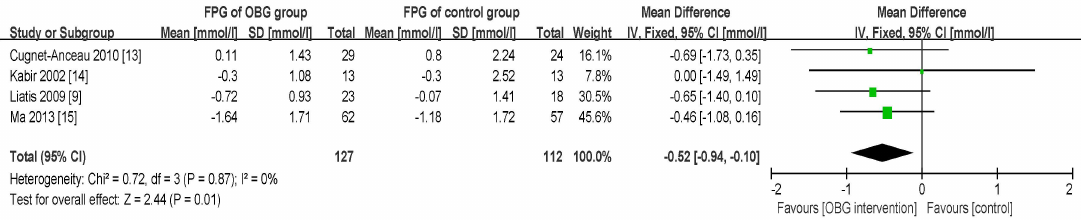
Figure 2. Forest plot for the effect of OBG intake on fasting plasma glucose (FPG) concentration. Data are expressed as mean differences in FPG concentration with 95% confidence intervals (CI). For